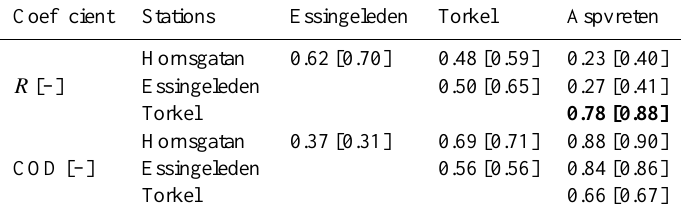
Table 2. Spatiotemporal variability of M LAC time series measured at the four sites in the period 20 April–5 July 2006. R and COD for hourly and daily (in square brackets) measurements. R> 0 . 75 are displayed in